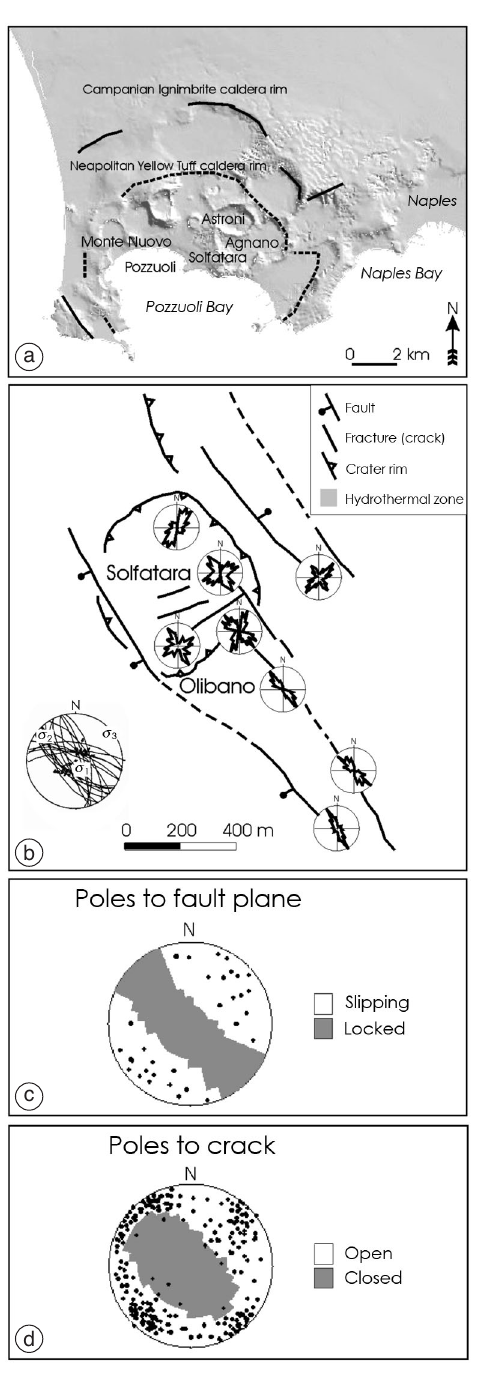
Fig. 1a-d. a) Sketch map of the Campi Flegrei caldera (from Orsi et al ., 1996). b) Structural map of the Solfatara area and summary of the mesostructural measurement in the Solfatara area. Fault-slip data and orientation of the stress axes are reported right down (Schmidt net, lower hemisphere projection; data from Chiodini et al ., 2001). The azimuthal distribution of the strike of cracks in different selected sites is plotted on Rose diagrams. Each measurement site does not ex- ceed 40 m 2 . c, d) Results of the stress field analysis on the Solfatara faults (c; λ= 0.16) and cracks (d; λ= 0.5). Poles to measured fault planes (upper panel) and crack walls (lower panel) are reported as dots (Schmidt net, lower